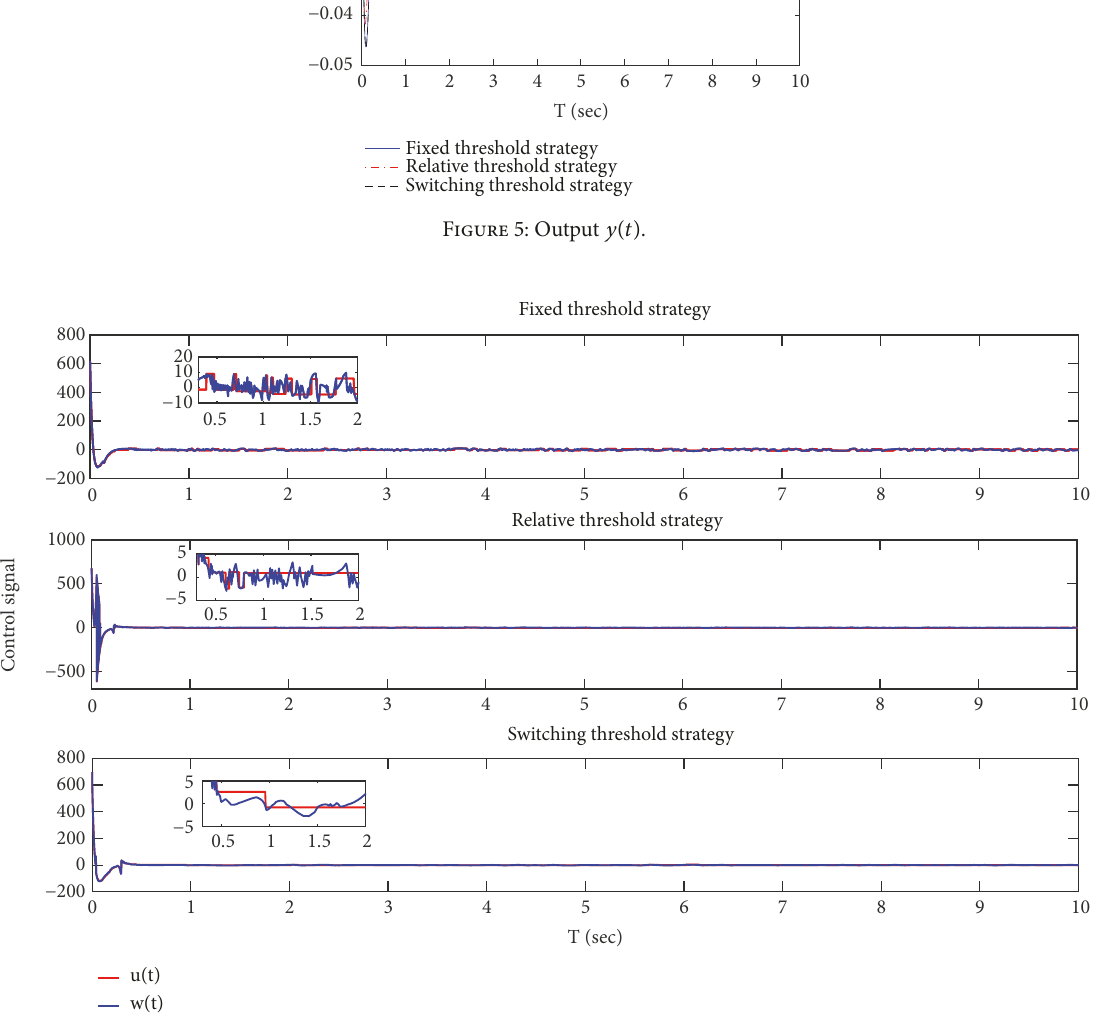
Figure 6: Control